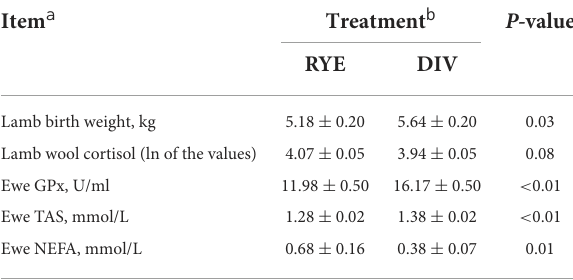
TABLE 4 Animal measurements for sheep allocated either a single forage perennial ryegrass diet ( Lolium perenne L. ; RYE) or a taxonomically diverse multi-forage choice (DIV) diet of ryegrass, chicory ( Cichorium intybus L.), alfalfa ( Medicago sativa L.), plantain ( Plantago lanceolata L.), and red clover ( Trifolium pretense L.) 24h after lambing.